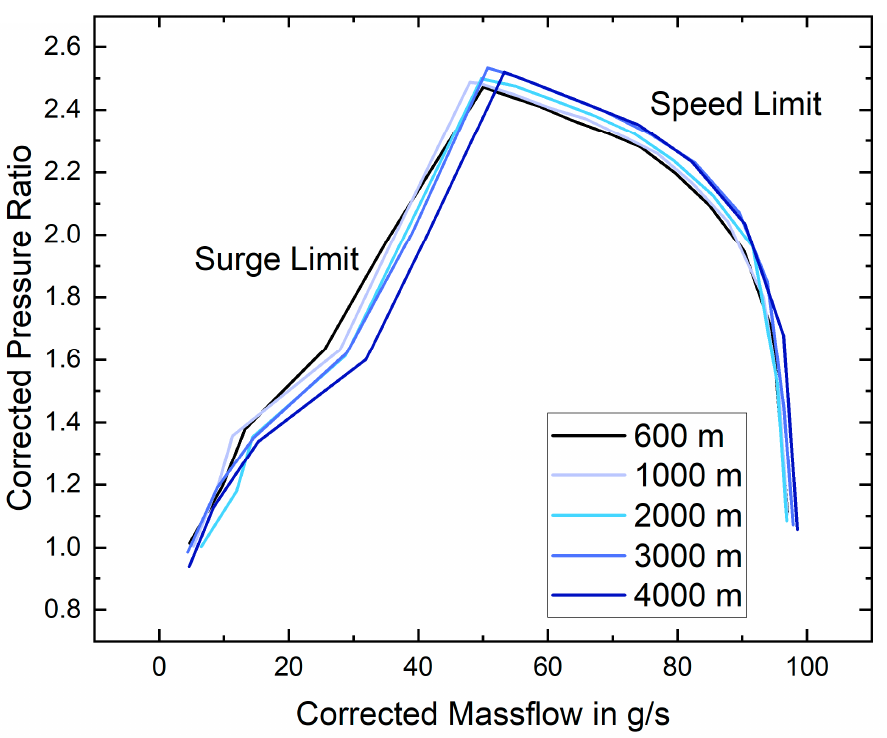
Figure 5. Pressure ratio over corrected air mass flow for measurements with simulated altitudes of 600, 1000, 2000, 3000 and 4000 m corrected to 0 m (15 °C, 1000 mbar(a)).